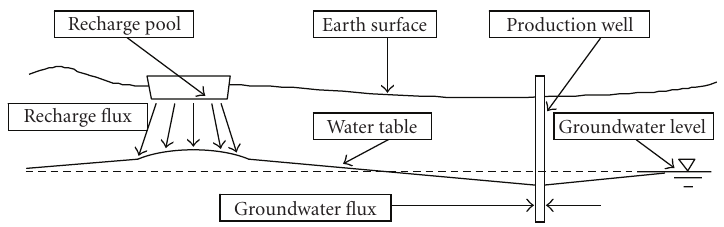
Figure 1: Schematic diagram of groundwater